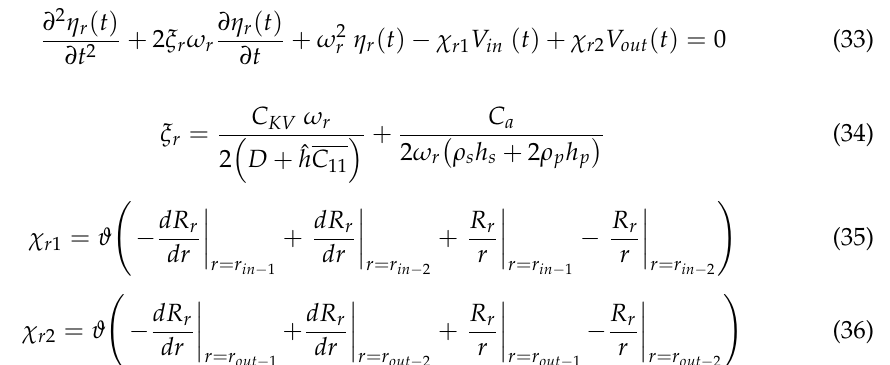
Figure 2. The mode shapes for the first three modes.